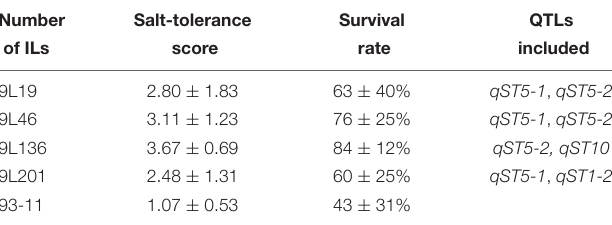
TABLE 3 | QTLs included in the introgressed segments carried by four selected salt-tolerant introgression lines.